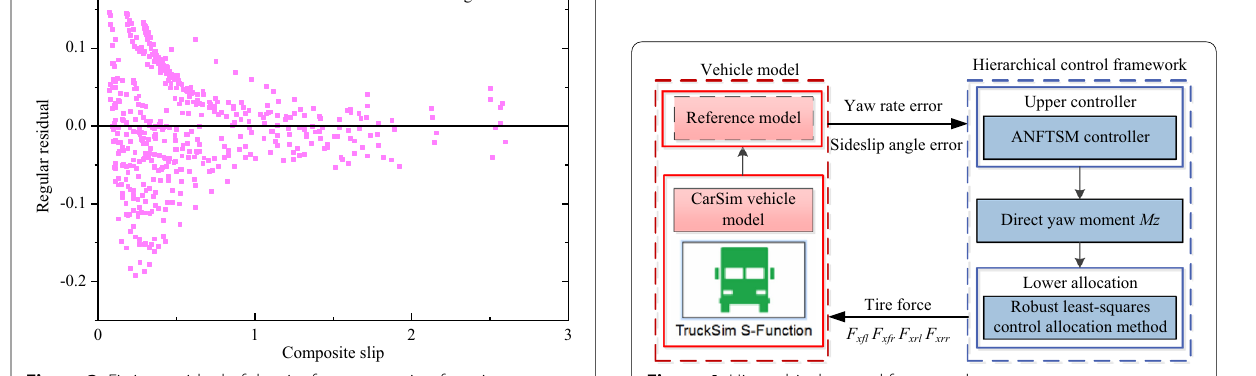
Figure 3 Fitting residual of the tire force saturation function